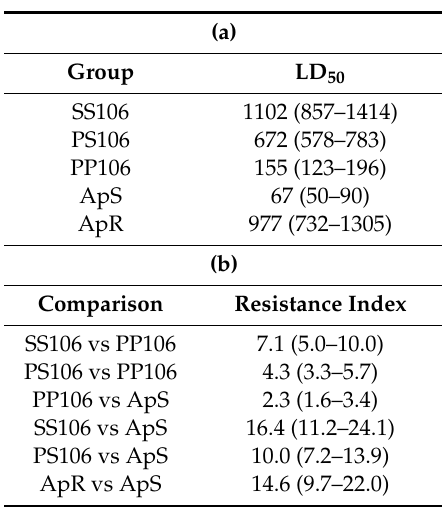
Table 1. LD 50 values ( a ) and resistance indices ( b ) estimated from the glyphosate dose-response test on five plant groups: ApS (standard sensitive), ApR (known resistant due to EPSPS gene duplication) and three characterised subpopulations (homozygous wild-type PP106; heterozygous PS106 and homozygous mutant SS106), arising from a cross between 52 PS106 individuals (95% confidence limits in